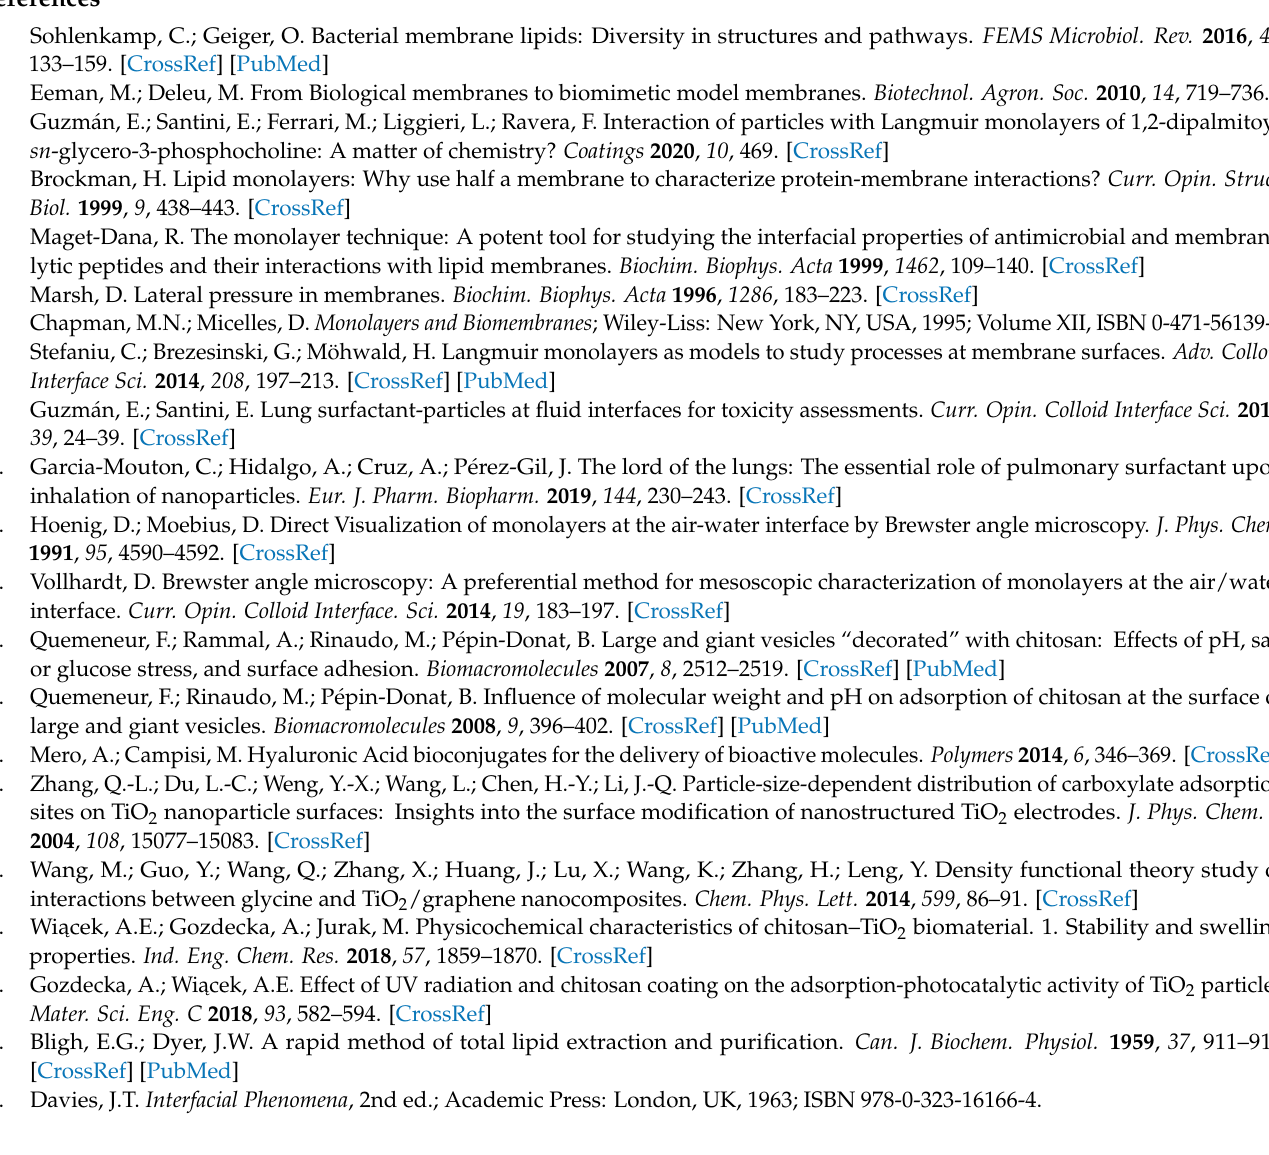
subphases; Figure S5: π -A isotherms obtained by means of the Langmuir technique and determined based on them C S − 1 = f( π ) relationships (inset) for the E. coli lipid film on biopolymers-containing subphases; Figure S6. Hysteresis loops obtained by compression and decompression of the E. coli lipid film on biopolymers-containing subphases; Figure S7. Hysteresis loops obtained by compression and decompression of the E. coli lipid film on TiO 2 -containing